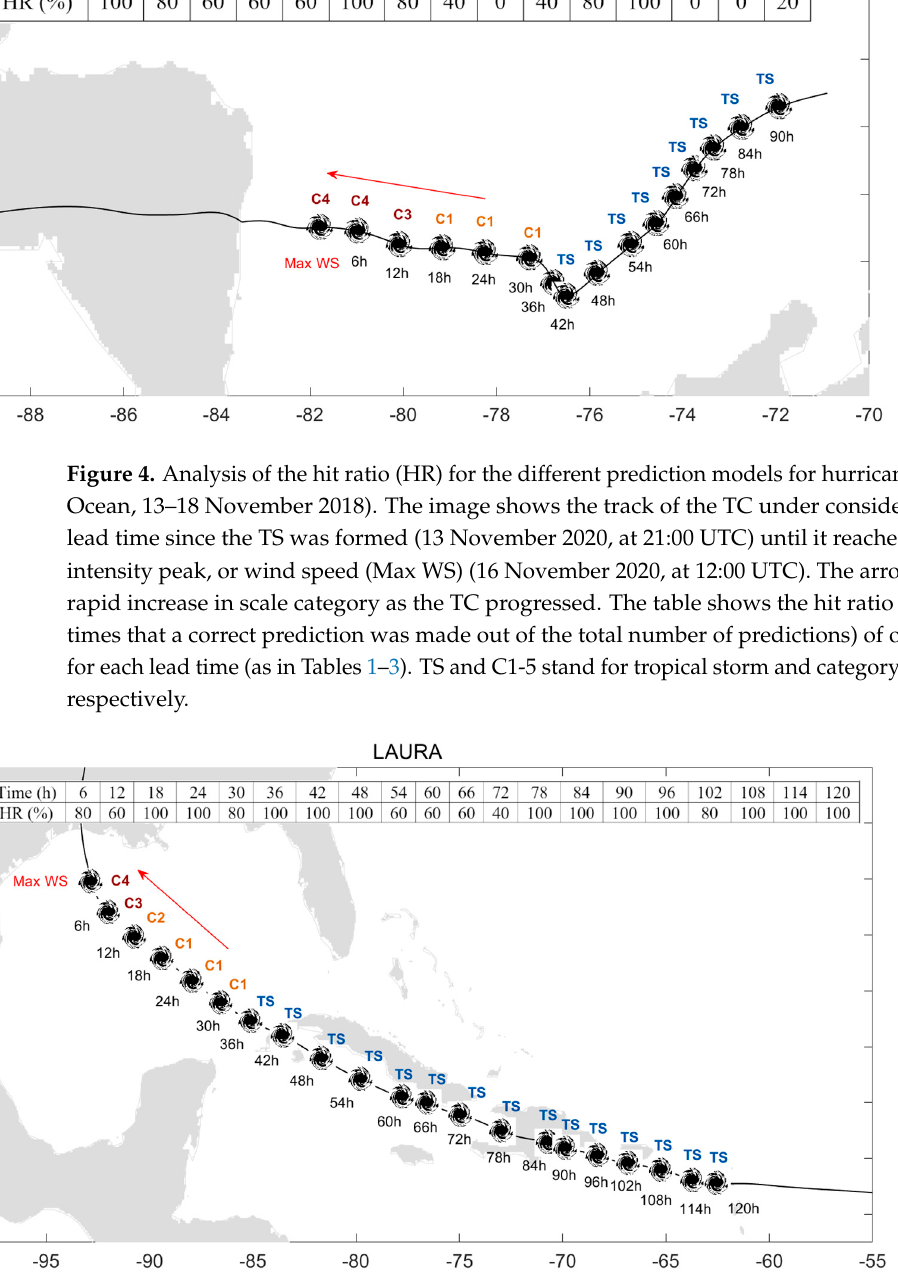
Figure 5. As in Figure 4, but for hurricane Laura (Atlantic Ocean, 20–29 August 2020). Here, the TS was formed on 21 August 2020, at 09:00 UTC and it reached the Max WS on 27 August 2020, at 00:00 UTC.